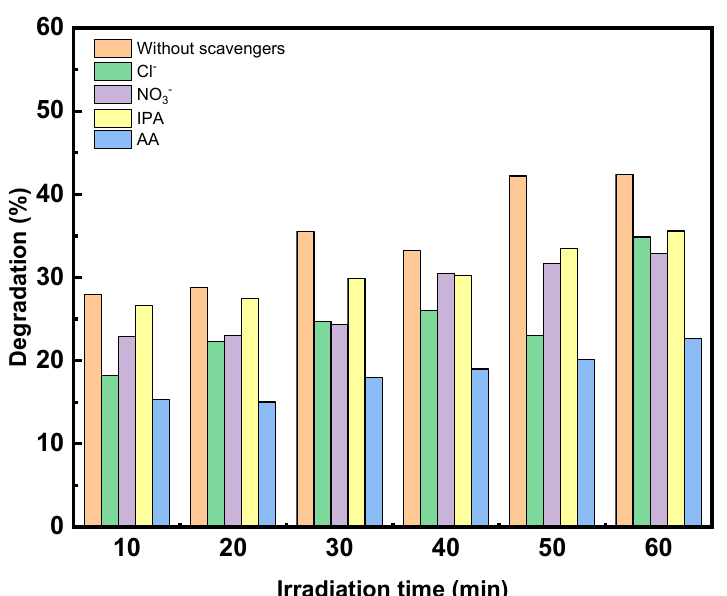
Figure 7. The degradation efficiency of trapping experiments of active species for the carmine photocatalytic reaction using 0.001 g of G/N-doped ZnO under UV light irradiation using 200 mM of scavengers.